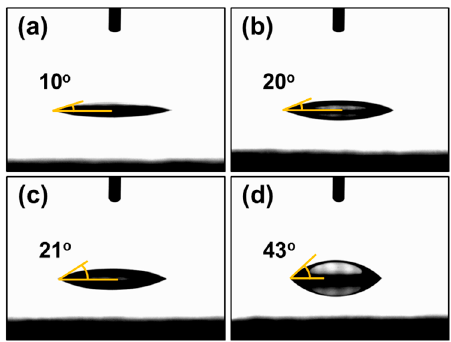
Figure 6. Water contact angle optical images of PEDOT:PSS and PEDOT:P(SS- co -VTMS) films with DMSO solution treatment. ( a ) PEDOT:P(SS- co -VTMS) 0 mol%, ( b ) PEDOT:P(SS- co -VTMS) 5 mol%, ( c ) PEDOT:P(SS- co -VTMS) 10 mol%, ( d ) PEDOT:P(SS- co -VTMS) 15 mol%.